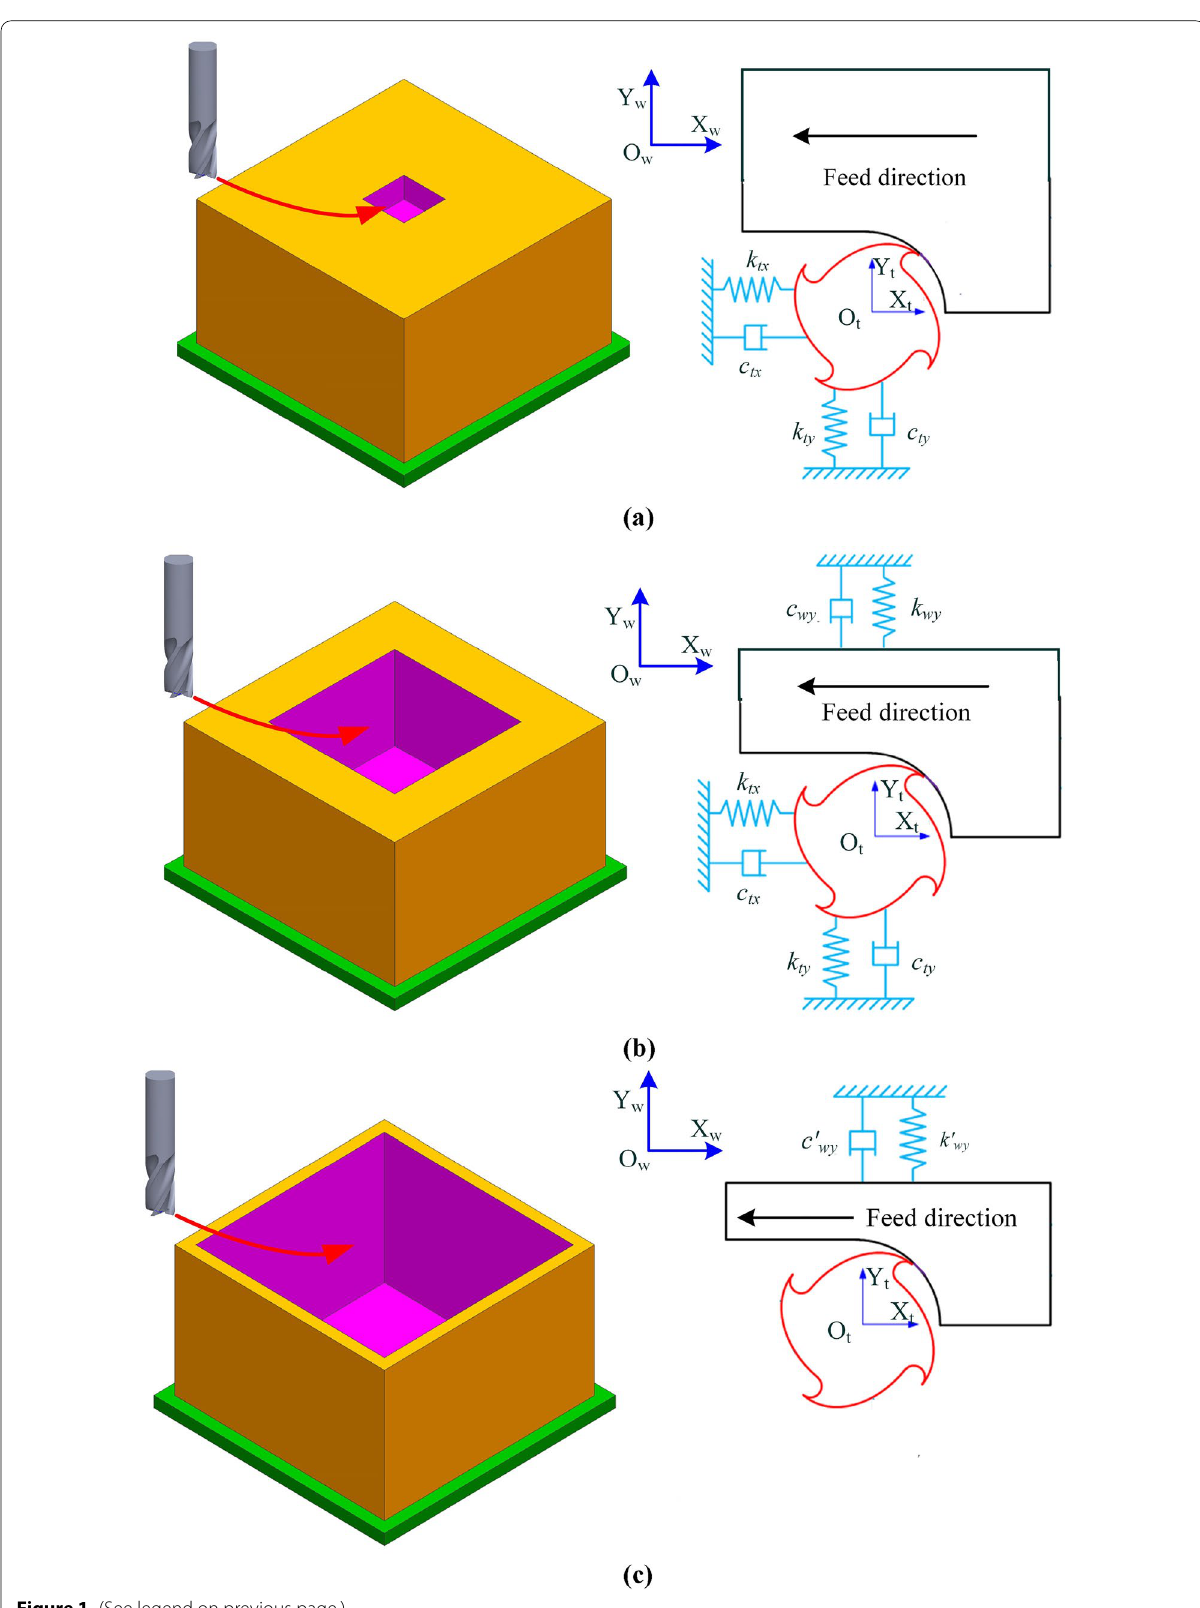
Figure 1 (See legend on previous